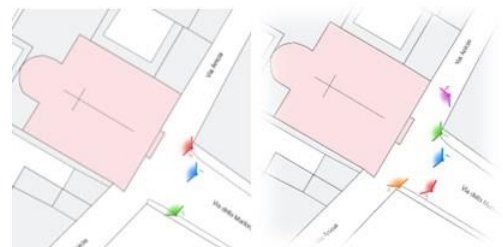
Figure 12 – S.Maria dell’Orto, configuration of three and five panoramas.